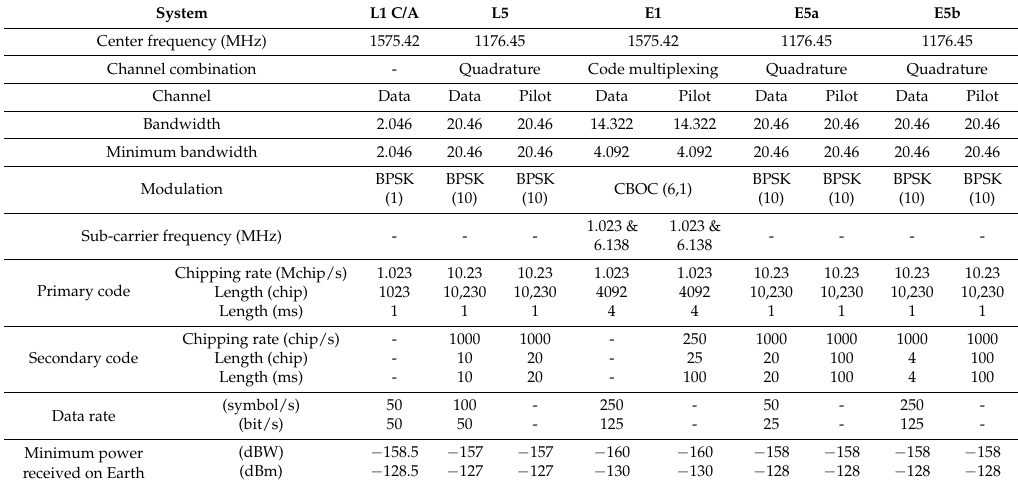
Table 1. Summary of the characteristics of the considered Global Navigation Satellite System (GNSS) signals. BPSK stand for Binary Phase Shift Keying, CBOC stands for Code Binary Offset